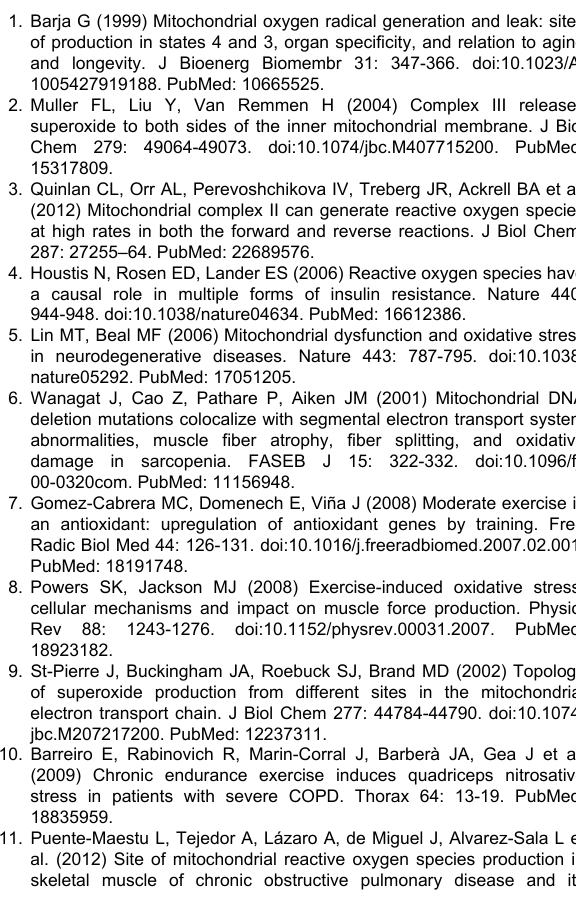
Figure S3. Immunoprecipitation (IP) control experiments. (A) The extent of TFAM depletion from mitochondrial lysate